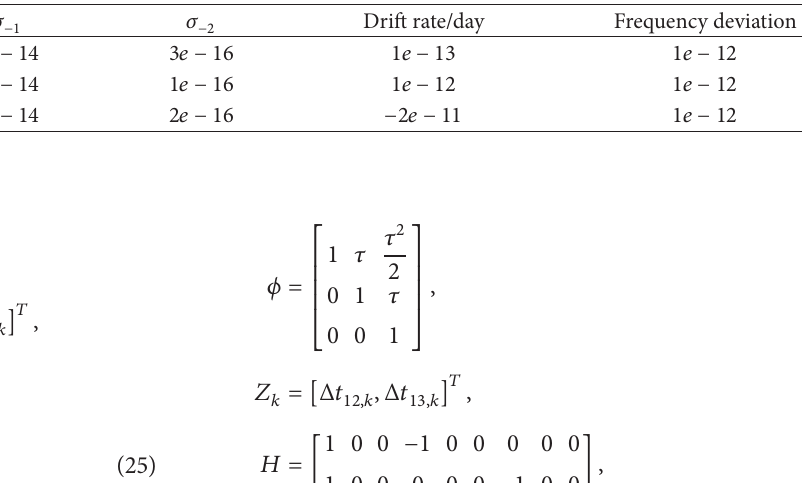
Table 13: Parameter